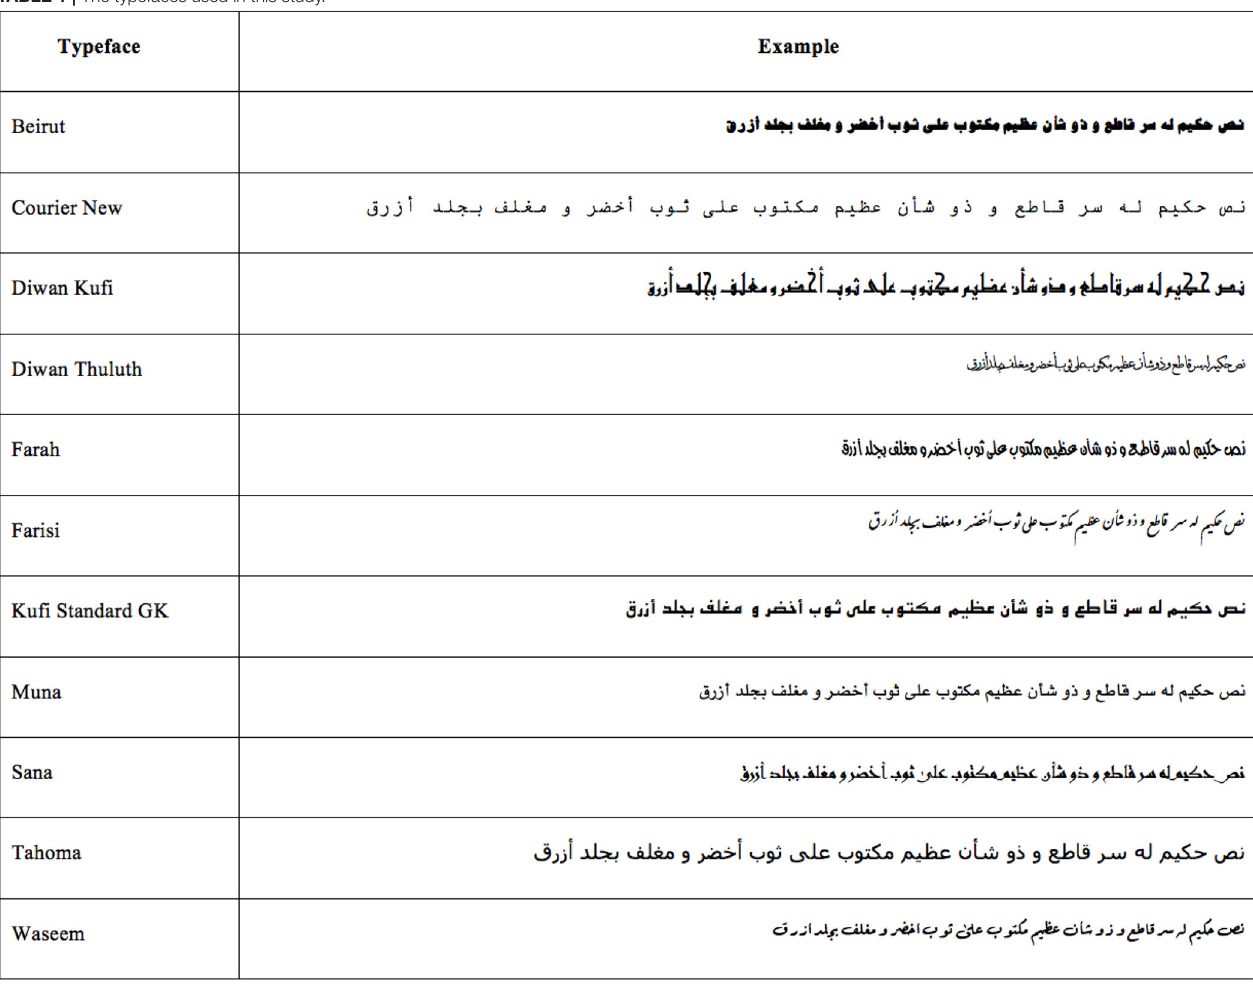
TABLE 1 | The typefaces used in this